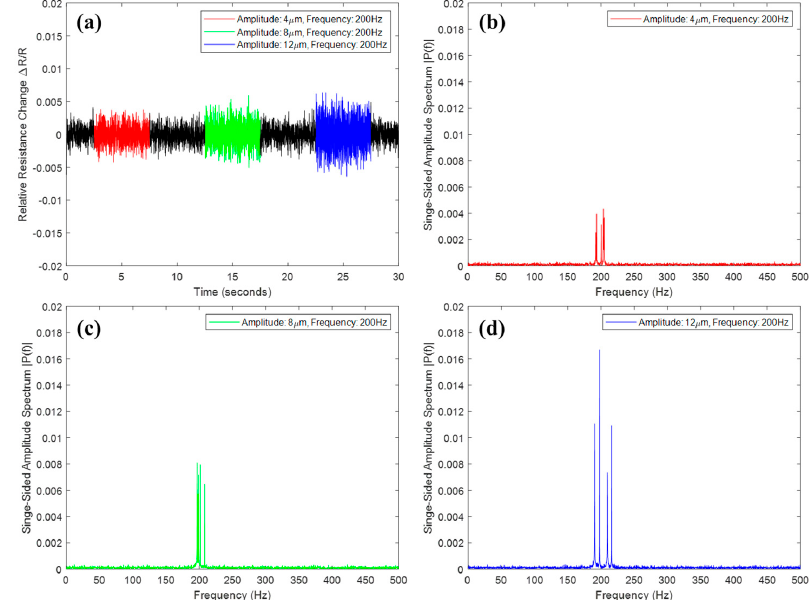
Figure 5. Experimental results according to the vibration amplitude. ( a ) Relative resistance change, amplitude spectrum of ( b ) 4 μ m, ( c ) 8 μ m, and ( d ) 12 μ m.